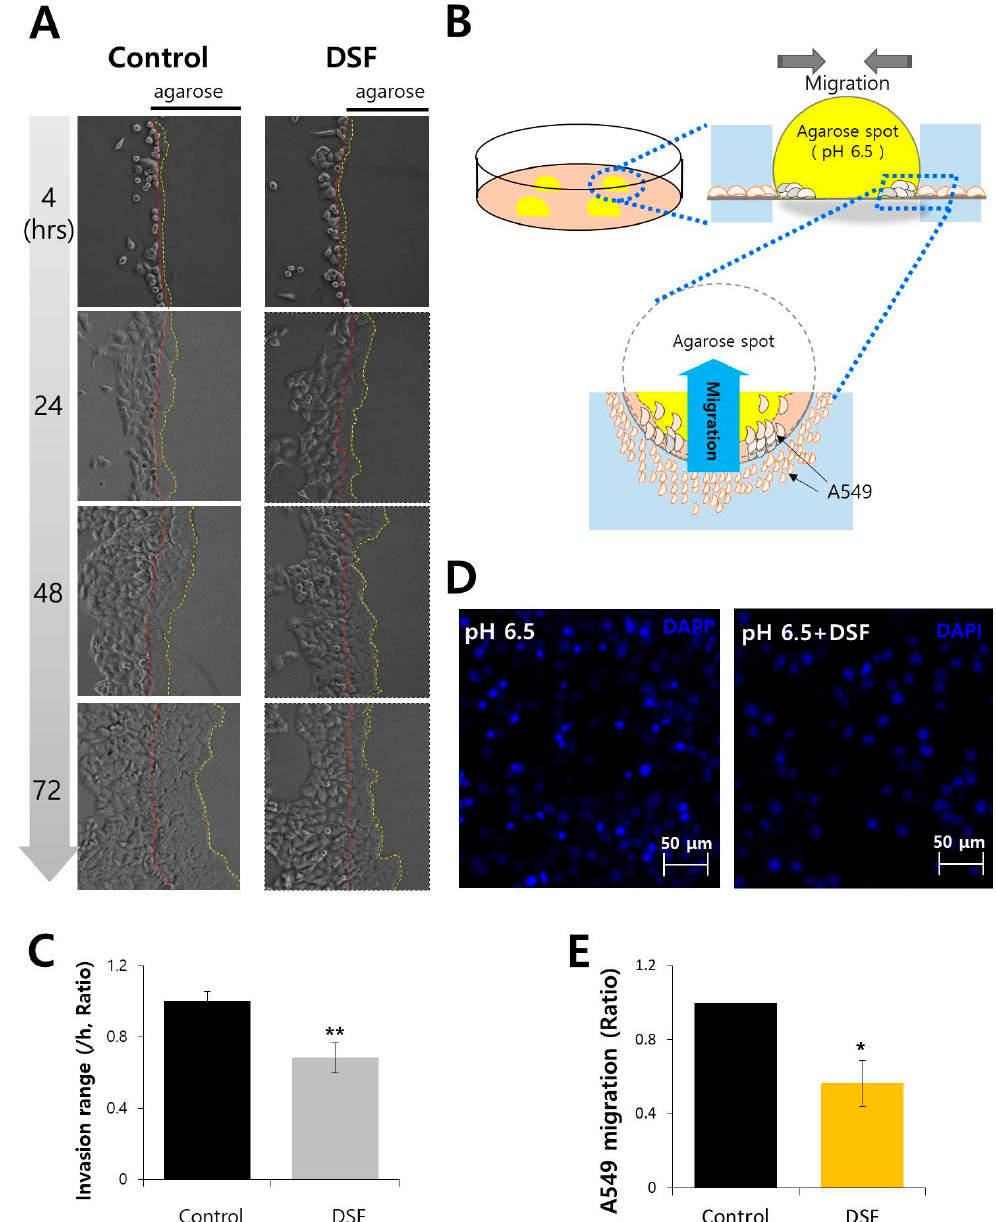
Figure 5 . DSF reduced cancer cell invasion and migration in acidic microenvironment . (A) Time dependent representative images of A549 cells, invading (4, 24, 48, and 72 hrs) towards agarose spots containing PBS (pH 6.5) with and without DSF treatment. The red dotted lines indicate the direction of invasion across the boundary of the agarose spot shown as a dashed curve. The yellow dotted lines indicate the lineage of cells that migrated into the agarose spots. (B) The schematic representation of agarose spot assay. (C) Analysis of invasion range per hour. Bars indicate the means ± SEM (n = 4, **p < 0.01). (D) A549 cell migration was measured by transwell-membrane migration assay incubated with indicated conditions (bottom plates; pH 6.5, upper chamber; pretreated with 2 μΜ DSF at 48 hrs). Immunofluorescence staining of nucleus (DAPI, blue) was analyzed for the evaluation of cell migration. The scale bars represent 50 μ m. (E) Analysis of total intensity of DAPI for A549 migration. Bars represent mean ± SEM (n = 3, *p < 0.05).